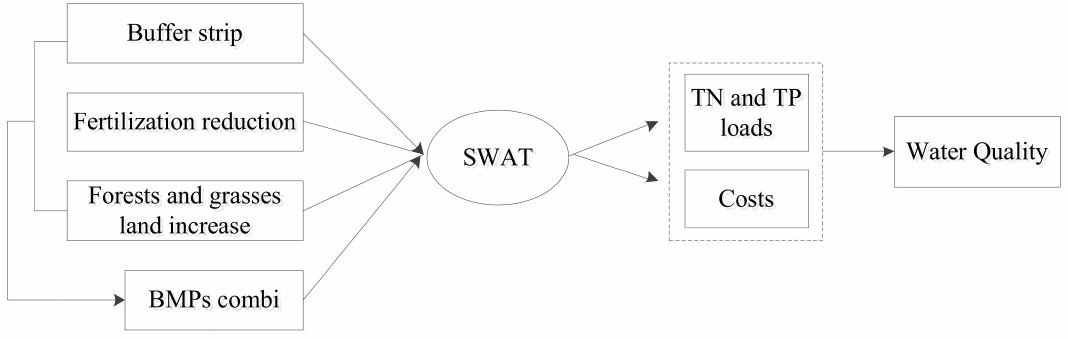
Figure 2. Technology route map of the study